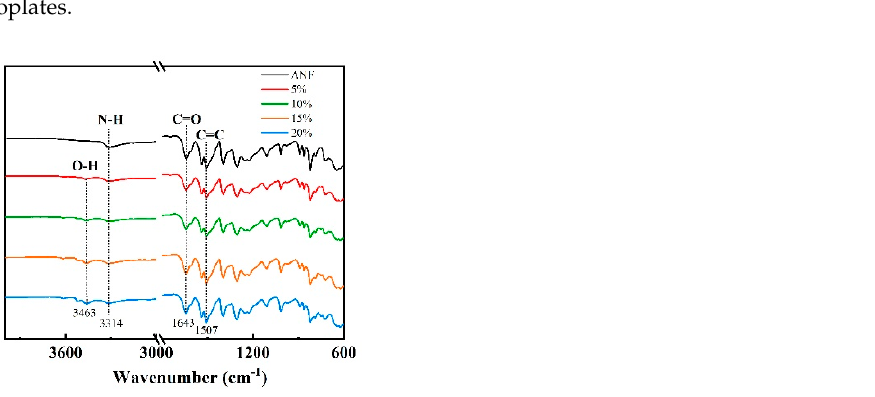
Figure 4. FT-IR curves of ANF/chitosan/Al 2 O 3 composite films with different contents of Al 2 O 3 na- noplates.